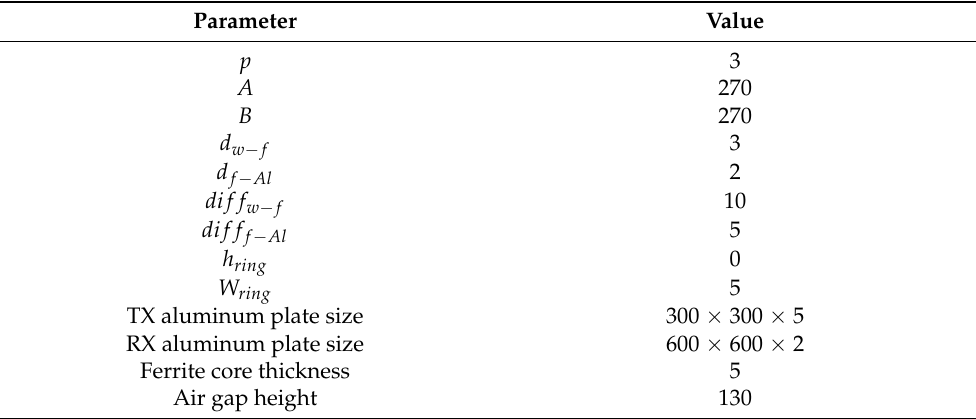
Table 2. Initial parameters of the coil assembly pair. The unit of all parameters is mm.